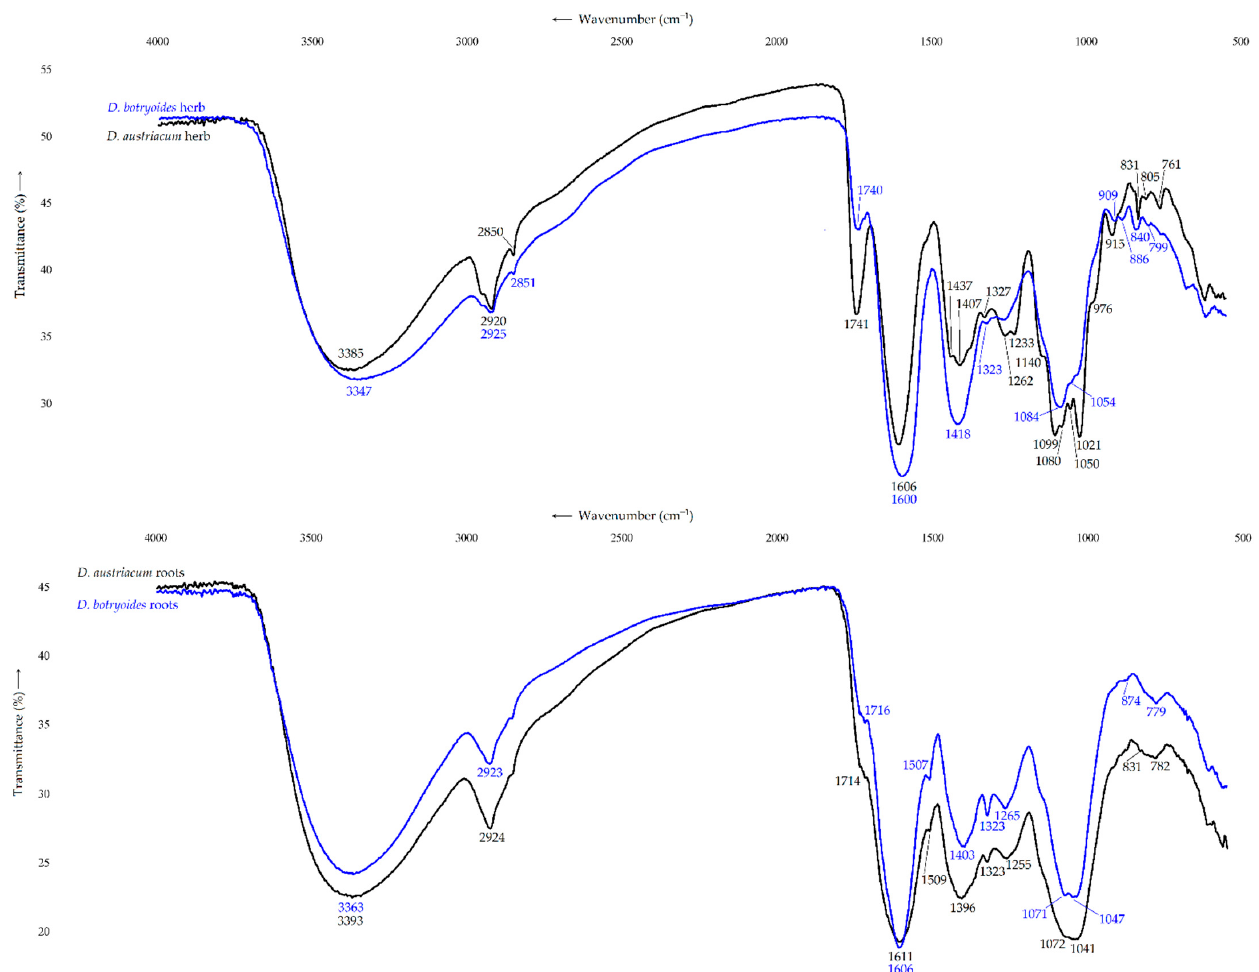
Figure 4. FTIR spectra of water-soluble polysaccharides of herbs and roots of D. austriacum and D. botryoides .